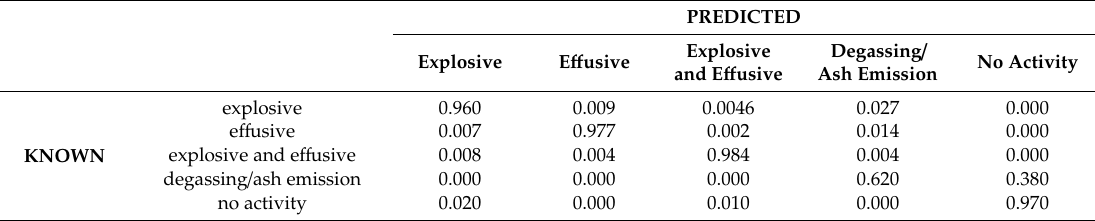
Table 8. Confusion Matrix of the BoW-based classifier. Each value of the matrix represents the number of observations that are correctly and incorrectly